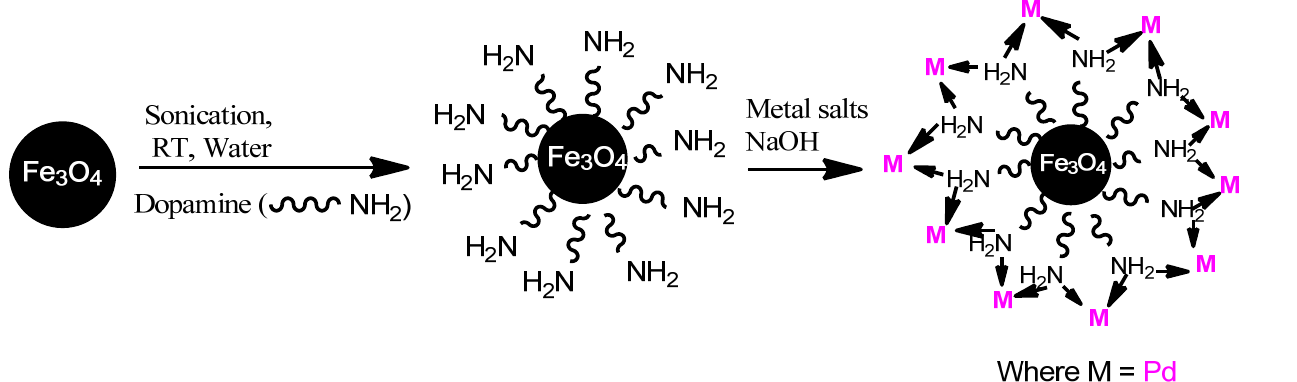
O –dopa–Pd] catalyst. Reprinted with permission from [36]. 3 4